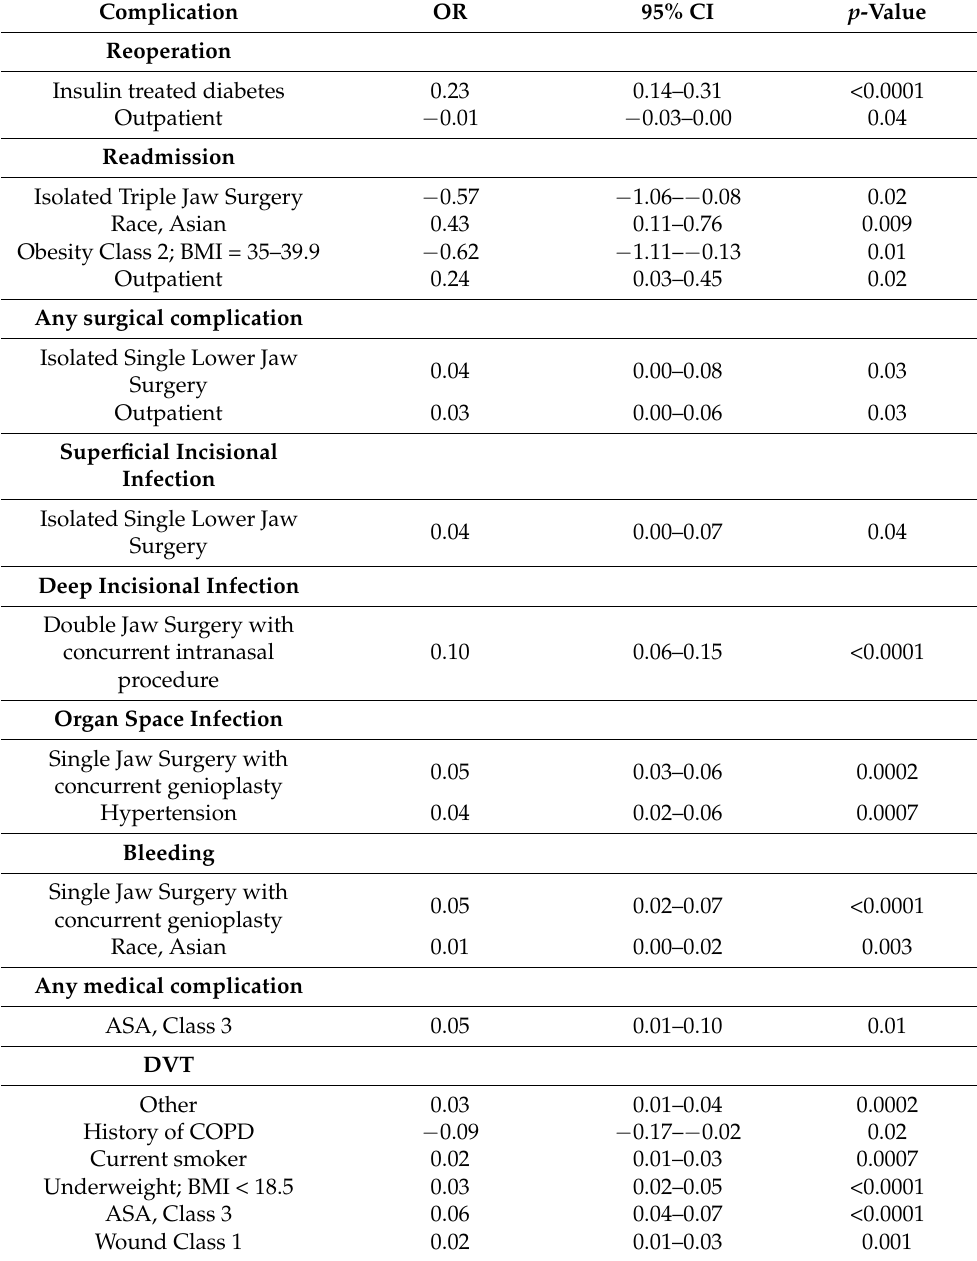
Table 8. Multivariable assessment of different complication occurrence for all jaw surgery